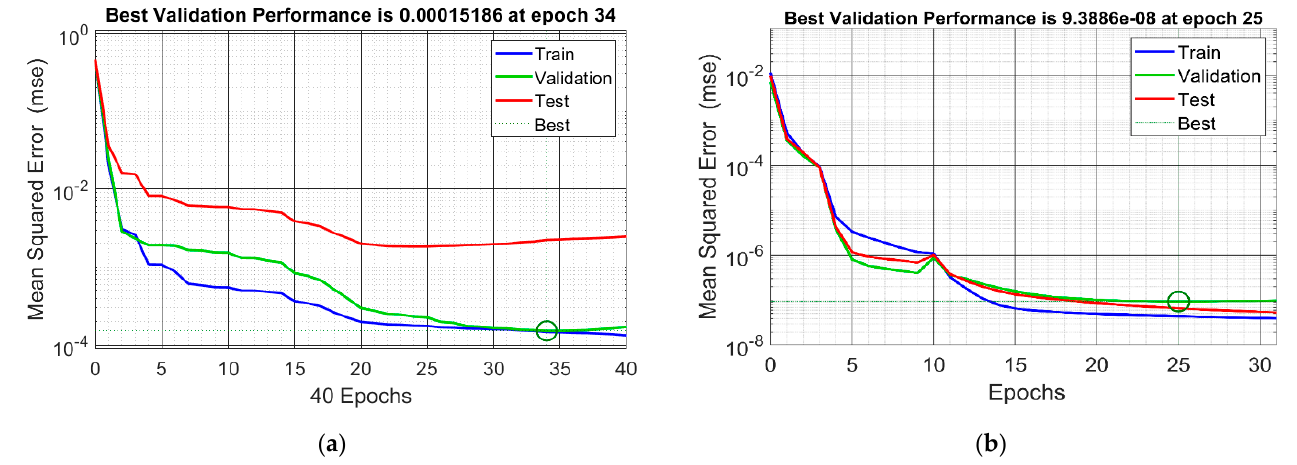
Figure 12. Best validation test of ( a ) conventional ANN and ( b ) optimised ANN. Table 3. The parameters of an optimal ANN.